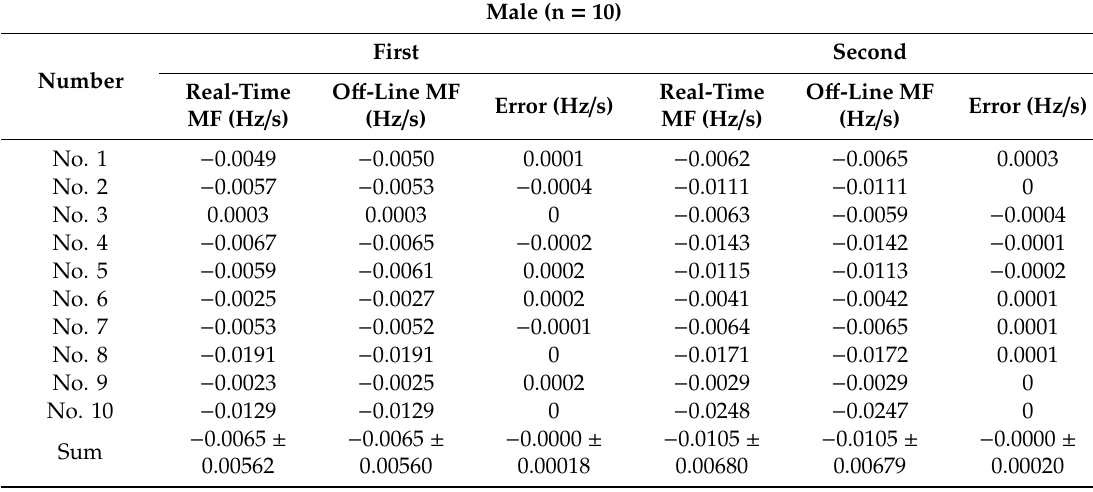
Table 3. All slope values of MF change for the ten male subjects.